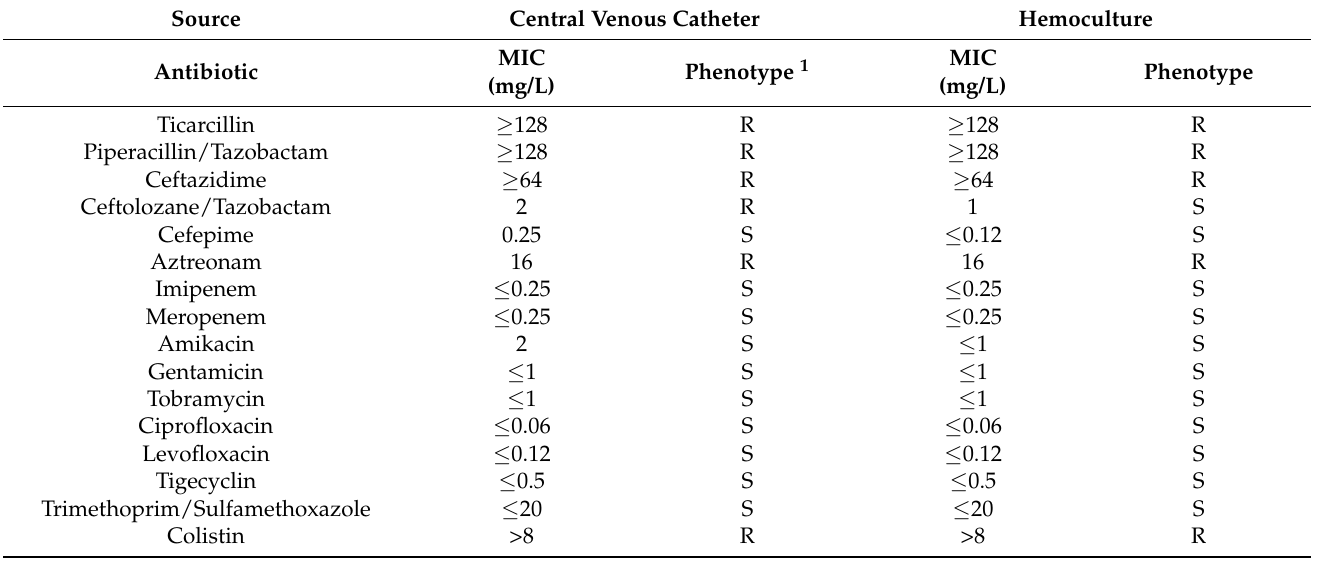
Table 1. Antimicrobial susceptibility profiles of E. cloacae complex ( E. bugandensis ) isolates. Source Central Venous Catheter